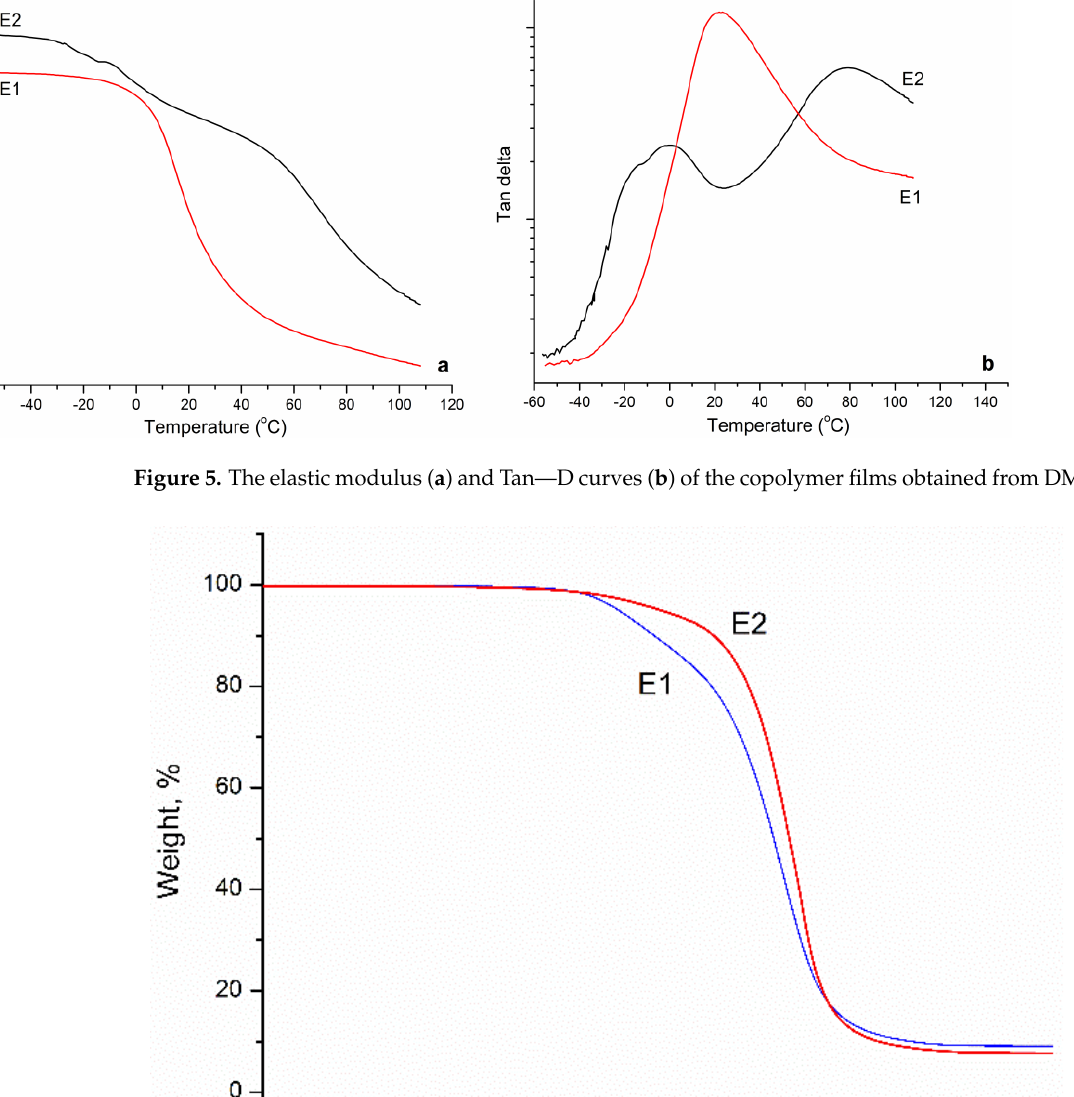
Figure 5. The elastic modulus ( a ) and Tan — D curves ( b ) of the copolymer films obtained from